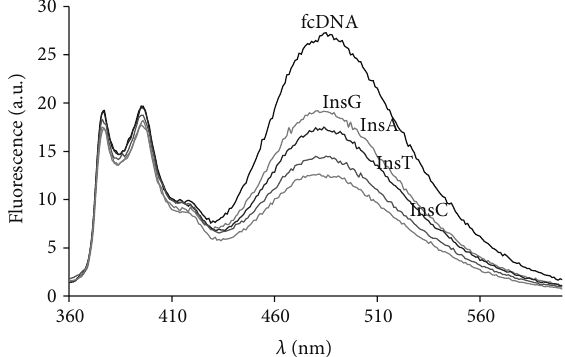
Figure 7: Fluorescent spectra of (IVb+IIa) duplexes with targets differing in the type of insertion (InsG, InsA, InsC, or InsT) in comparisontospectrumofduplex(IVb+IIa) ⋅ fcDNA.Seeconditions Figure